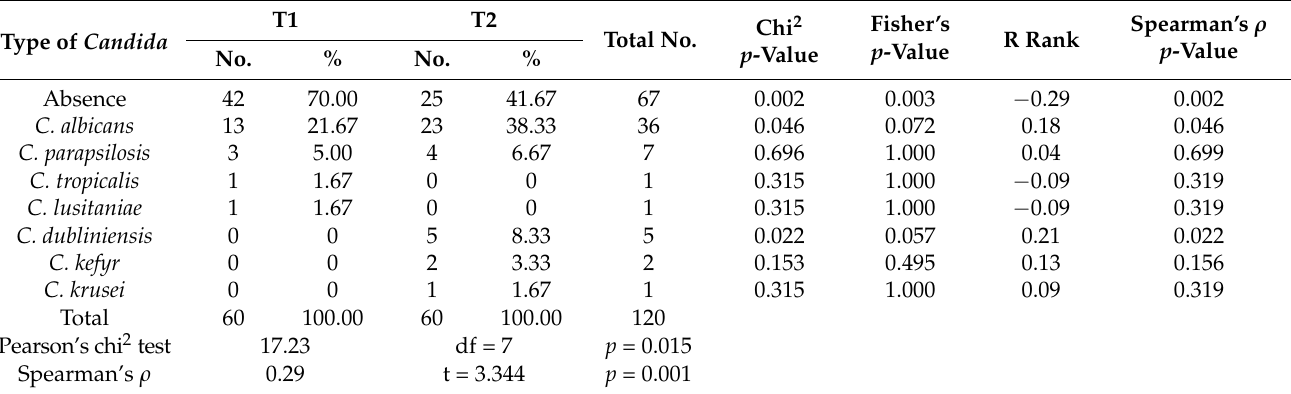
Table 1. Relationship between the prevalence of each type of Candida to the time at which the study was conducted.